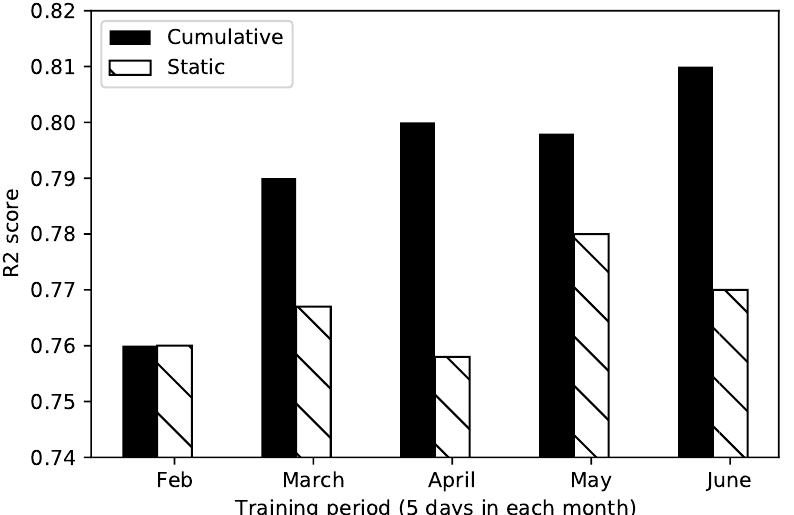
Figure 13. Long Short-Term Memory (LSTM) model